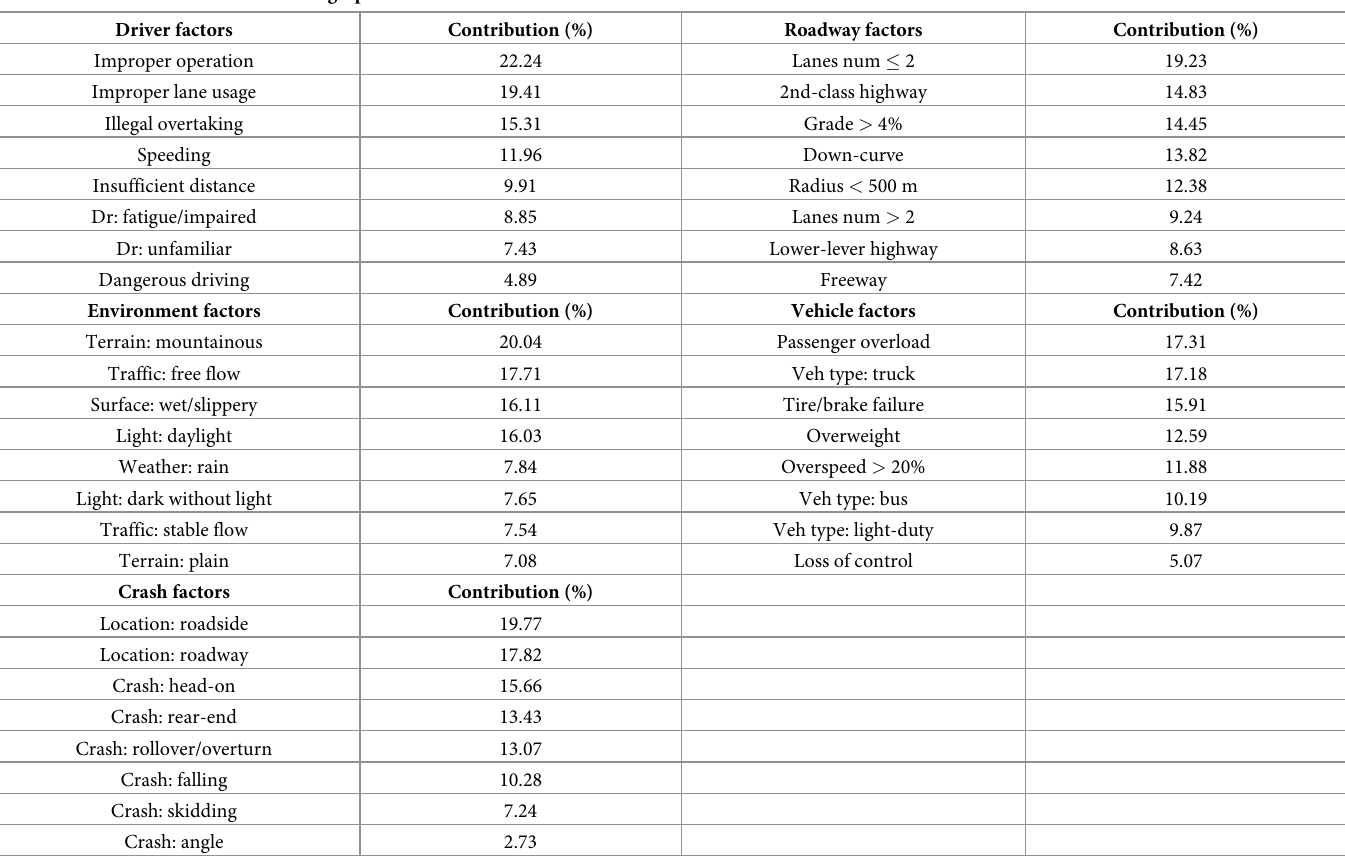
Table 2. Contributions of factors to the graph structures based on